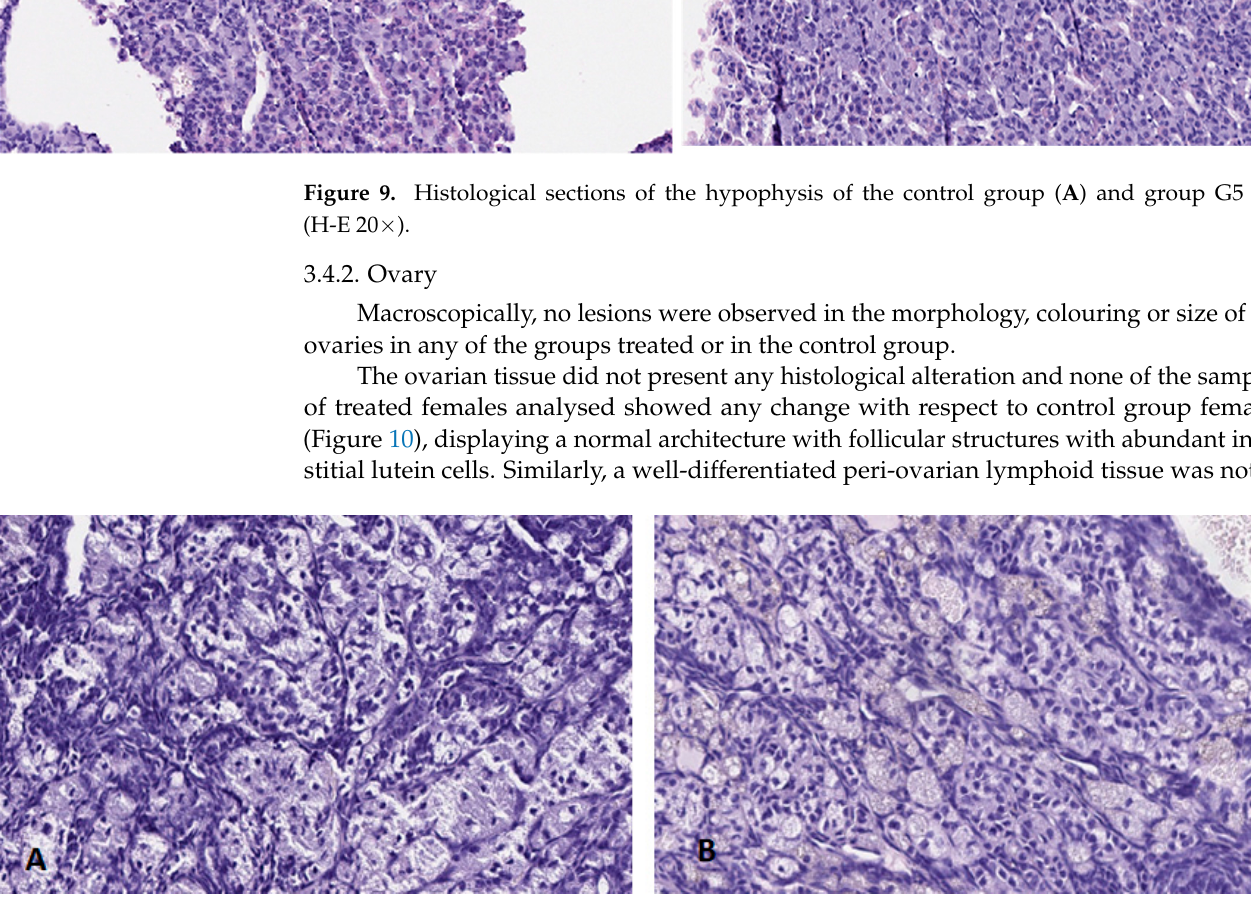
Figure 10. Histological sections of ovaries in female mice from the control group ( A ) and group 5 ( B ), (H-E 20×). (H-E 20 ×